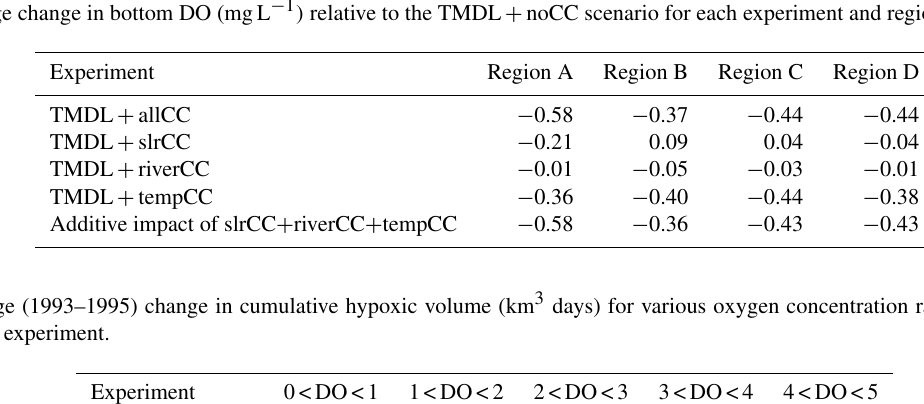
Table 3. Average change in bottom DO (mgL − 1 ) relative to the TMDL + noCC scenario for each experiment and region. Experiment